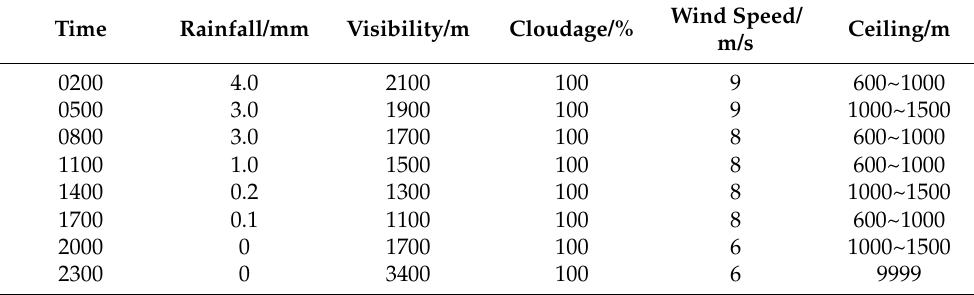
Table 3. 24-h observation data of Nanjing Weather Station.